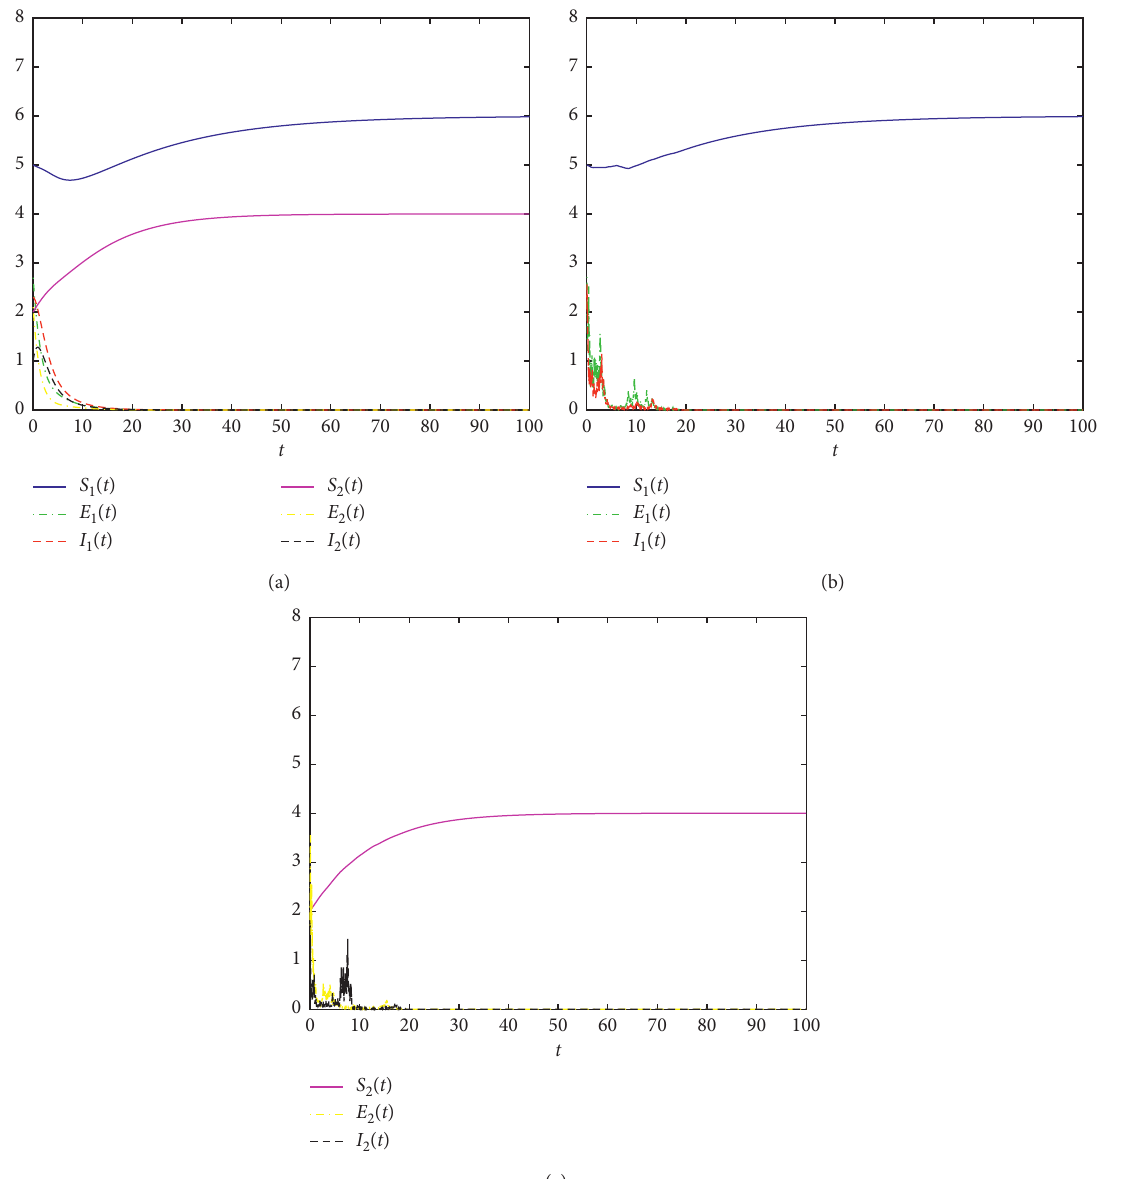
( 0 ) � 5 , E ( 0 ) � 2 . 7 ,I ( 0 ) � 2 . 3 ; S ( 0 ) � 2 , E ( 0 ) � 2 . 1 ,I ( 0 ) � 1: 1 1 1 2 2 2